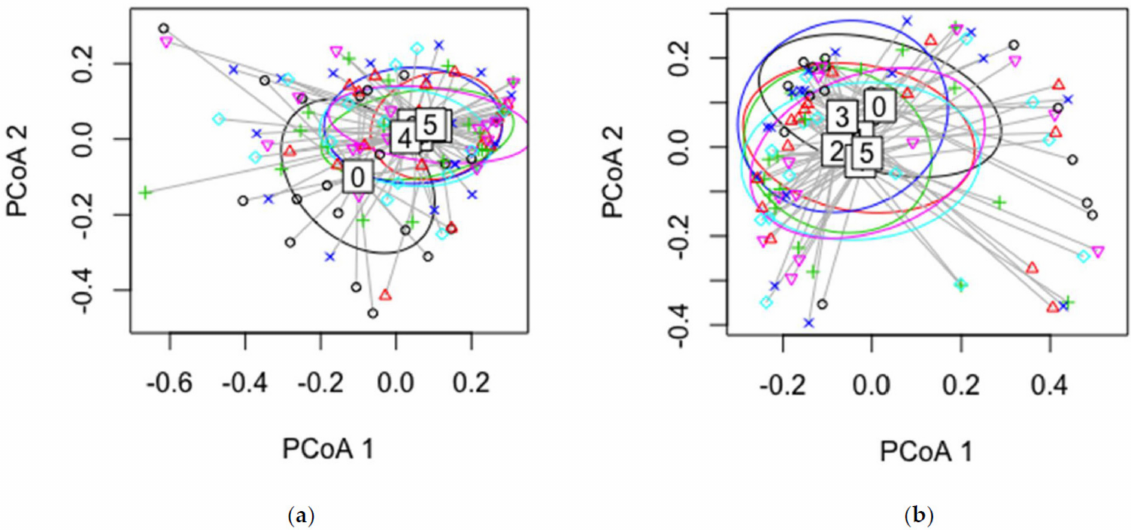
Figure 5. Dispersion of species in the culture-based isolation data ( a ) and OTUs in the HTS data ( b ) for each sample (permutation test using the bray method) in each disease class.